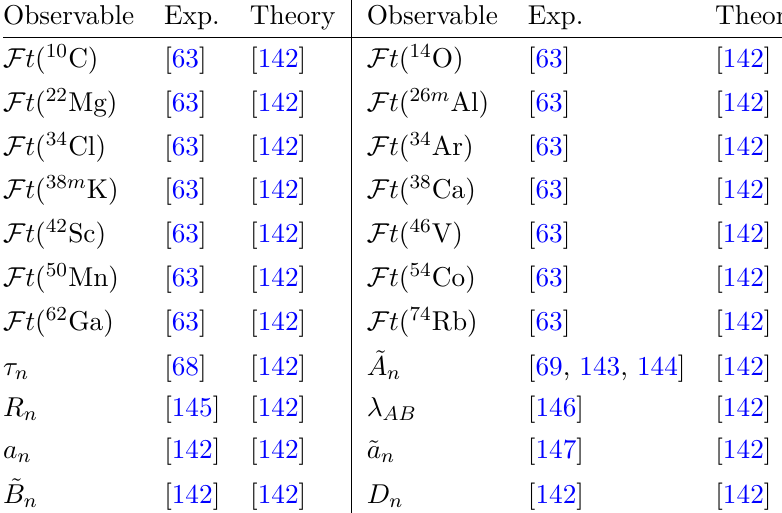
Table 6 . The “beta” observables used in smelli , along with the relevant experimental measurements and theory papers used in the computation.